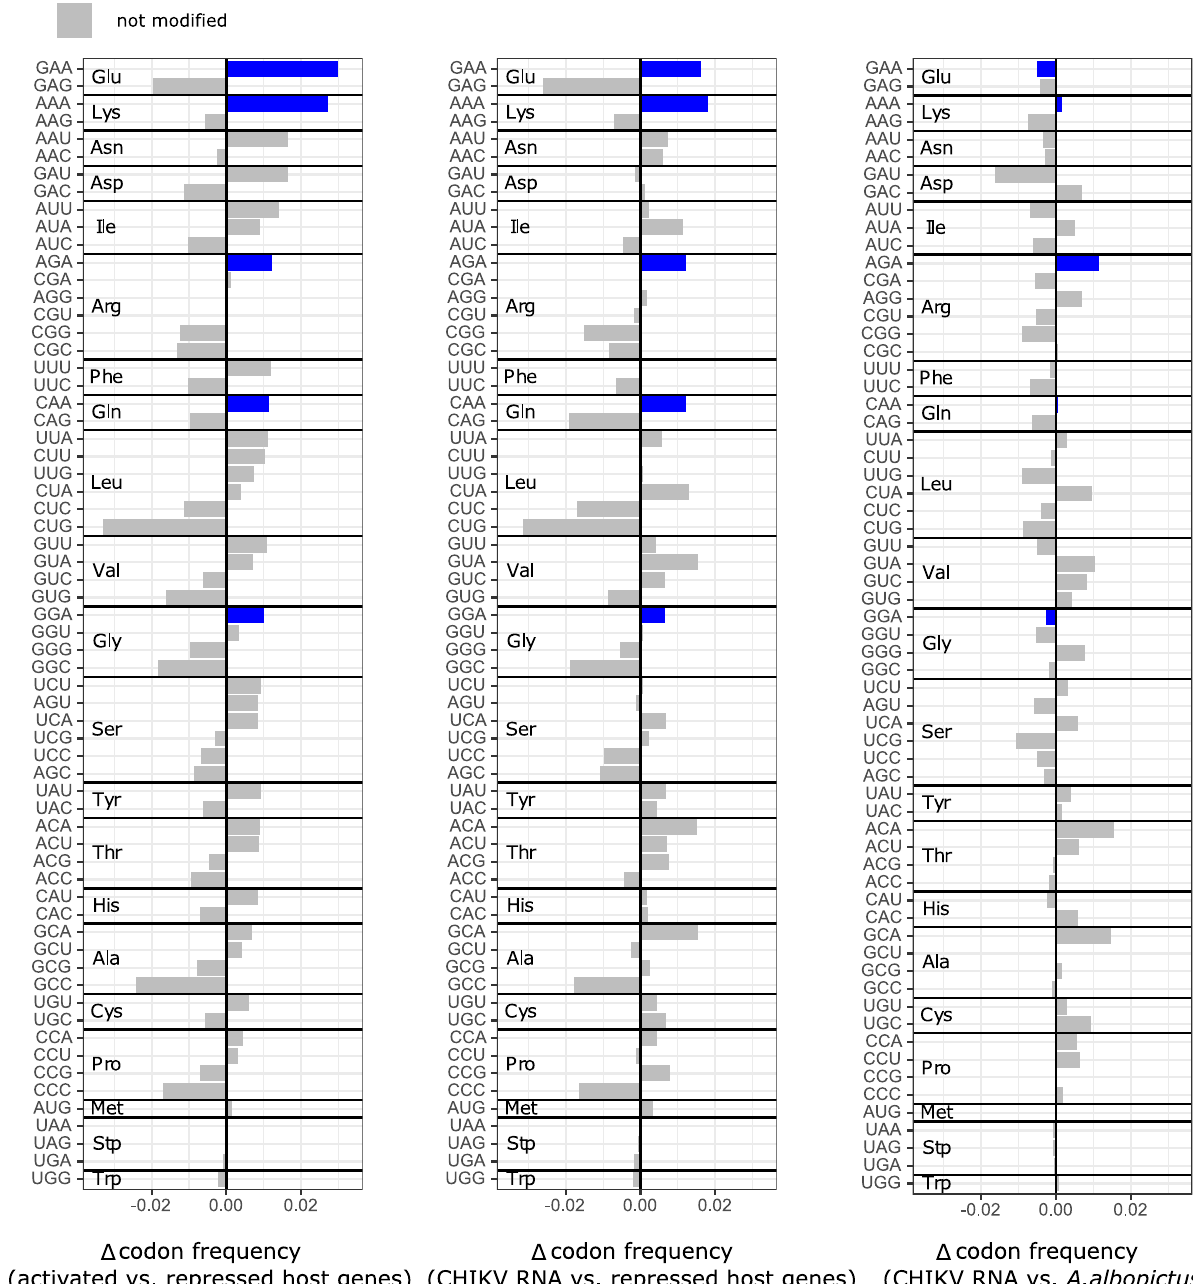
Fig. 4 CHIKV infection induces codon usage reprogramming in human cells. Difference in mean codon frequency (see Fig. S13) for translationally activated host genes compared to translationally repressed host genes (left panel), for CHIKV RNAs compared to translationally repressed host genes (middle panel) or for CHIKV RNAs compared to the Asian tiger mosquito Aedes albopictus , a known vector (right